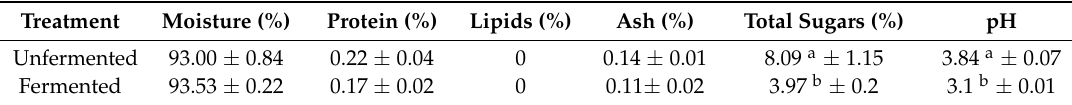
Table 1. Centesimal composition and pH of blueberry and carrot blend unfermented and fermented by Lactobacillus reuteri . Results are expressed as mean values of three repetitions followed by the standard